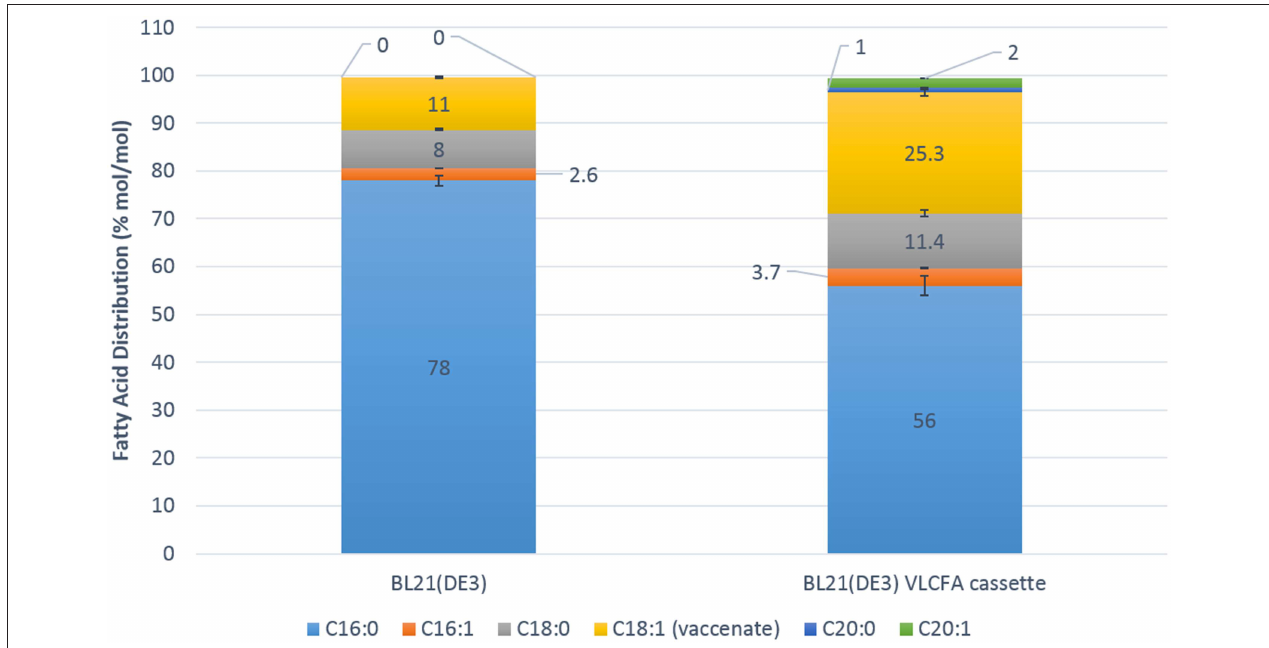
FIGURE 6 | Fatty acid distribution mol/mol of the 1.3L Fermentation of the control Escherichia coli BL21 (DE3) expressing pACYC-11-saGFP and pET28a-1-10saGFP vs. BL21 (DE3) expressing pACYC-VLCFA-11GFP and pET28a-1-10GFP. The BL21 (DE3) VLCFA cassette profile clearly shows the production of longer than C18 fatty acids (C20:0 and C20:1) which are absent in the control in addition to increases in stearic and vaccenic